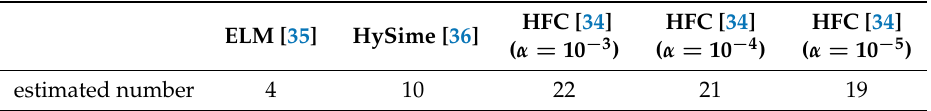
Table 9. Numbers of endmembers estimated in the ORB0041 image by the use of the ELM, HySime and HFC